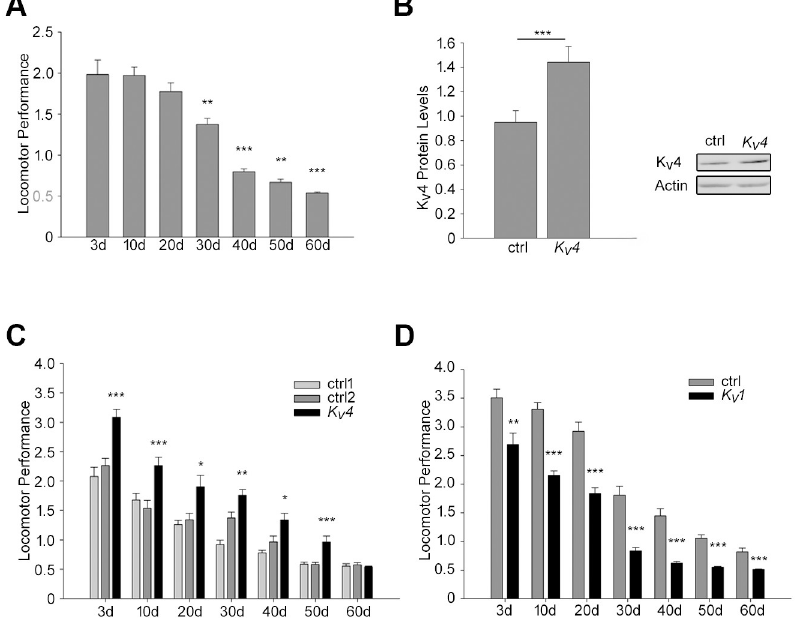
Fig 2. Age-related decline in locomotor performance improved by over-expression of K v 4/Shal. (A) Locomotor performance scored from climbing assays performed, as described in text, on male wild-type flies aged at 25˚C for indicated days. (B) Representative immunoblots and quantitative analyses for K v 4/Shal protein in heads from elav- GAL4 >> UAS-K v 4 (K v 4) and the UAS-K v 4 background control (ctrl) flies aged 3 days (N = 20). (C) Locomotor performance scored from climbing assays performed on genetic background control lines, elav-GAL4 (ctrl1) and UAS-K v 4/Shal (ctrl2), and elav >> UAS-K v 4/Shal (K v 4); flies were aged at 25˚C for the indicated days. (D) Locomotor (ctrl) and elav-GAL4 >> UAS-K performance scored from climbing assays performed on male UAS-K v 1/Shaker v 1/ Shaker (K v 1); flies were aged at 25˚C for the indicated days. For all assays, 35–40 flies per group, N = 10 groups per genotype were tested for each time point, shown are mean values +/- SEM; � p < 0.05, �� p � 0.01, ��� p � 0.001, Student’s